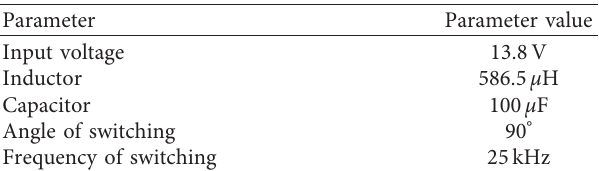
Figure 12: Diagram of designing a PI controller using PSO for controlling four-phase interleaved boost converter circuit voltage. Table 1: Summary table of the parameter value of the four-phase interleaved boost converter